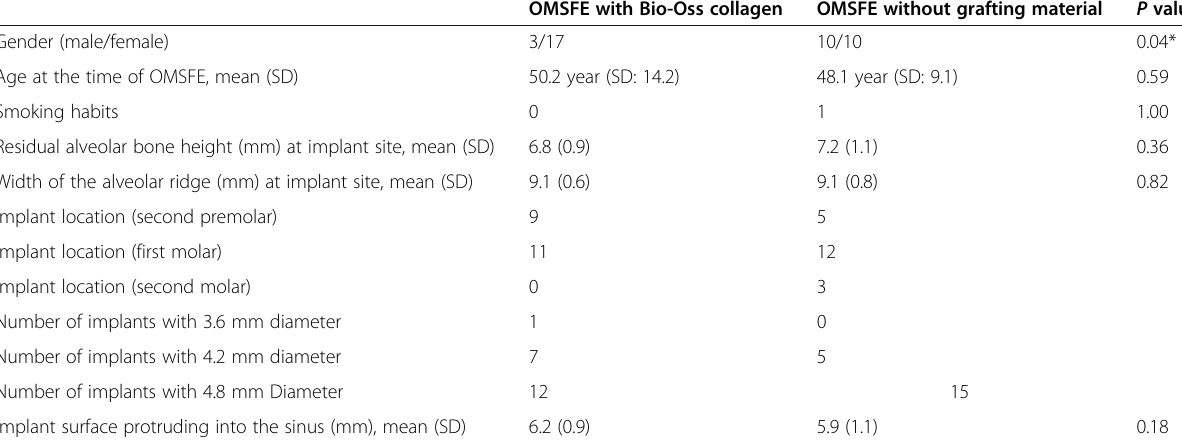
Table 2 Demographic characteristics of included patients OMSFE with Bio-Oss collagen OMSFE without grafting